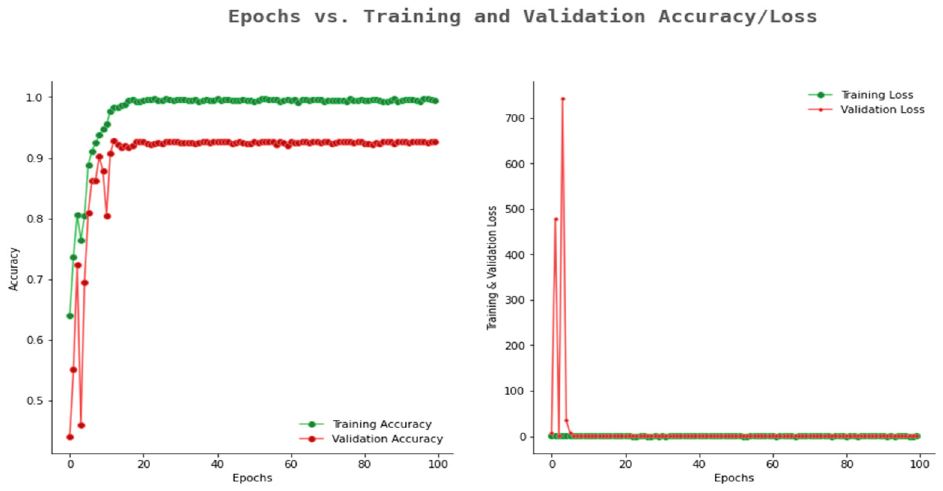
Figure 12. Accuracy and loss graph of Inception Net.